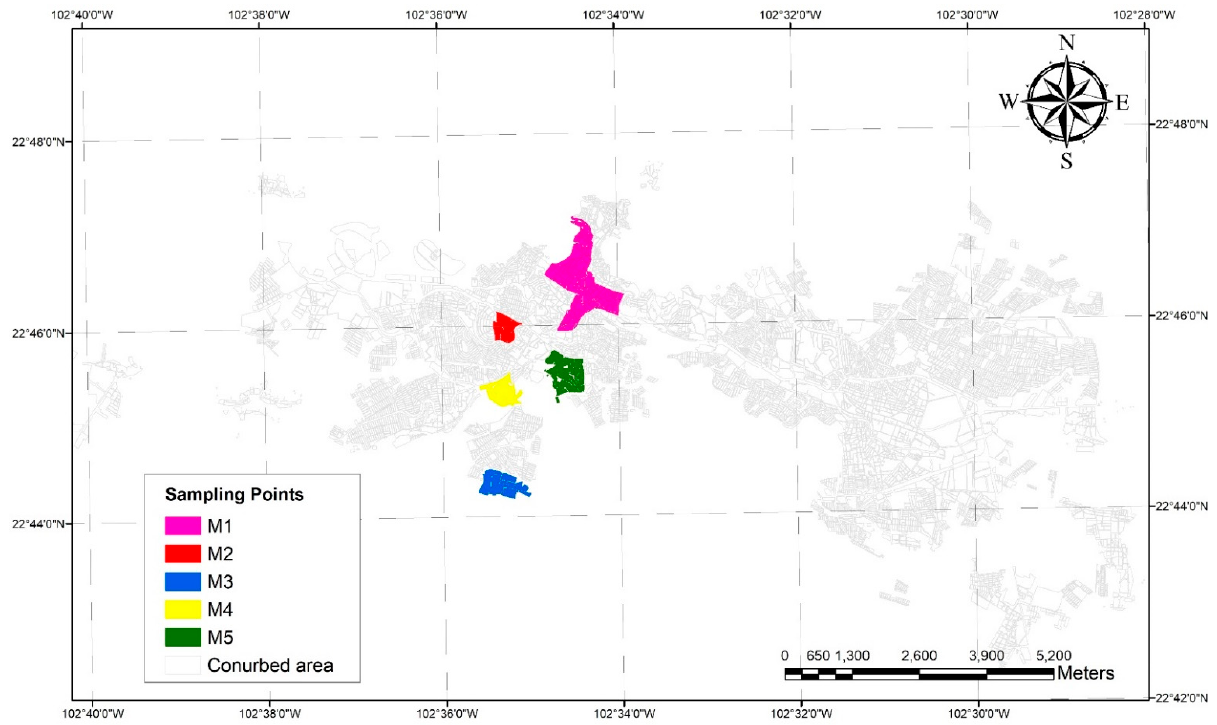
Figure 2. Sampling points in the conurbation area.